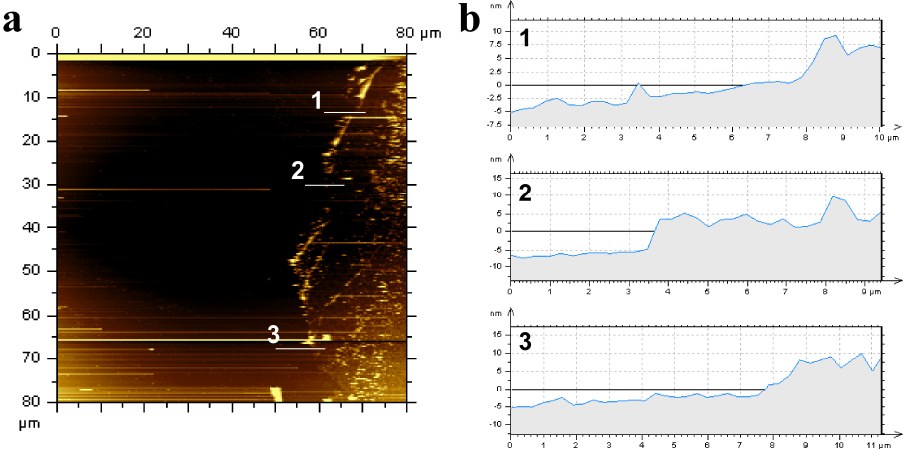
Figure 5. ( a ) AFM image of a continuous graphene film on silicon wafer with some brighter spots exhibiting wrinkles and overlapping. Line scans were performed to determine the thickness of the graphene films. ( b ) Corresponding height profile of the various line scans revealing the thickness of graphene film to be ~5–15 nm demonstrating formation of few layer graphene films.